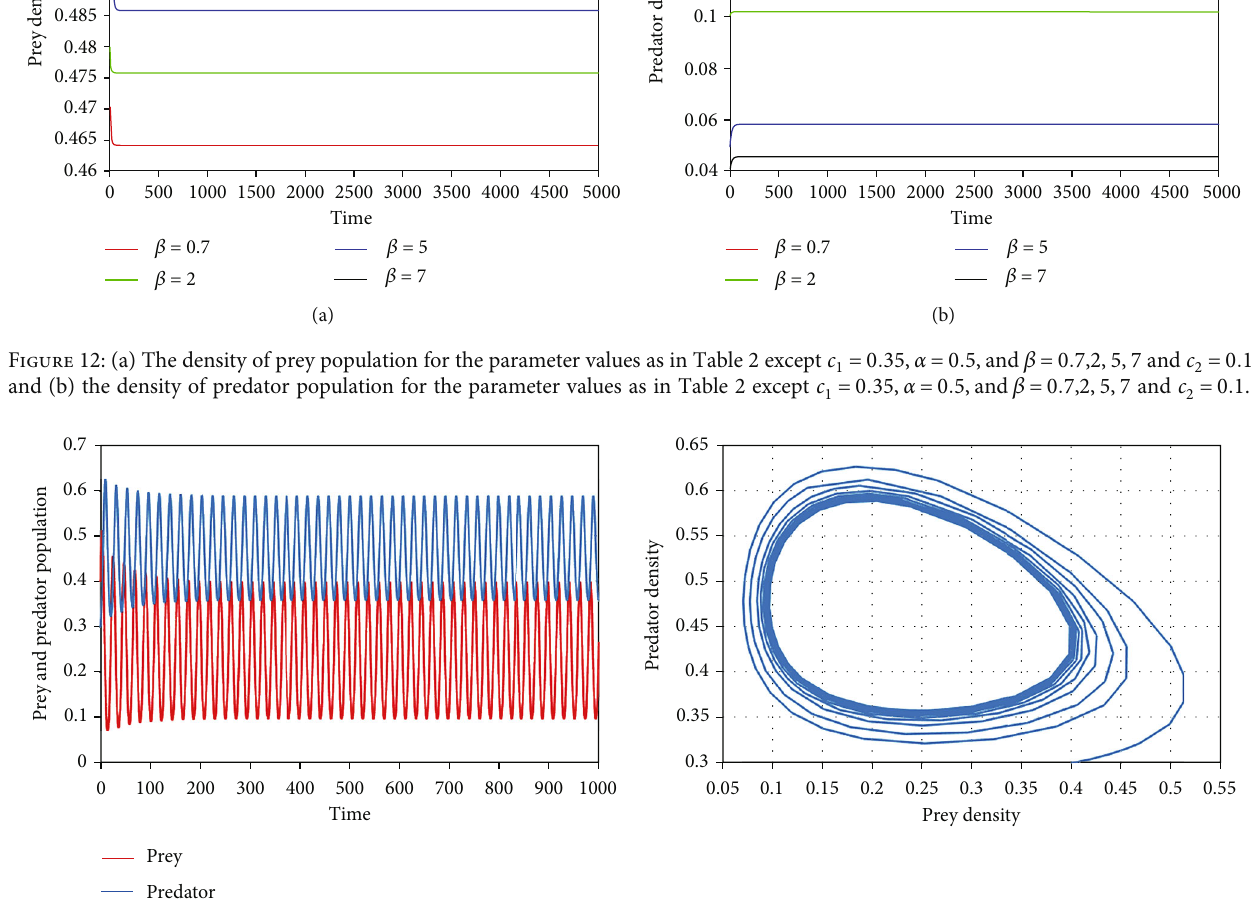
Figure 13: (a) Time series solution and (b) parametric plot of system (4) about the equilibrium point E except c 2 = 0 : 05, c 1 = 0 : 12, α = 1 : 9, and β = 0 β = 0 : 95 . Figure 11(a) shows that the stability of system (4) approaches asymptotically to the predator-free equilibrium point (axial equilibrium point) E 1 for β = 10 . Furthermore, one can see that the prey species coexist whereas the preda- range 0 : 159042 < β < 9 : 966312 . From Figures 12(a) and 12(b), it can be observed that an increase in the fear strength leads to an increase in the prey population density and a decrease in the predator population density.